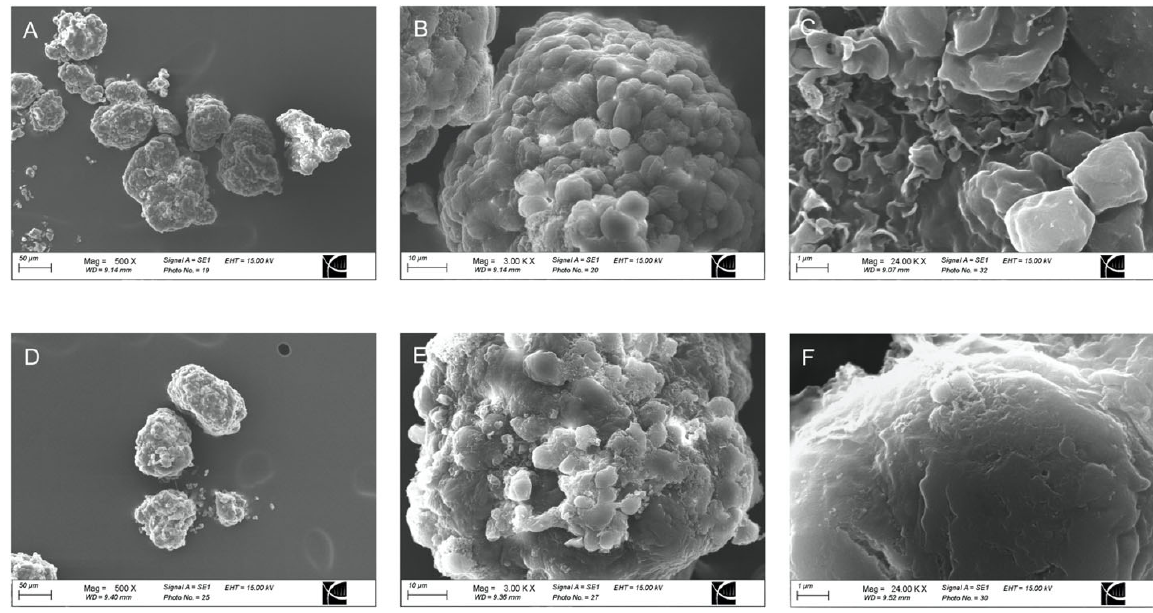
Figure 2. Representative scanning electron microscopy micrograph of non-coated ( A – C ) and PVPON/TA-coated ( D – F ) human islets at 500× ( A , D ), 3000× ( B , E ), and 24,000× magni fi cation ( C , F ).